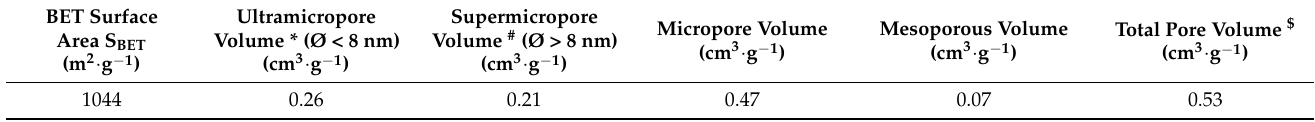
Table 3. Textural properties of AC by N 2 adsorption at 77 K and CO 2 adsorption at 273 K.